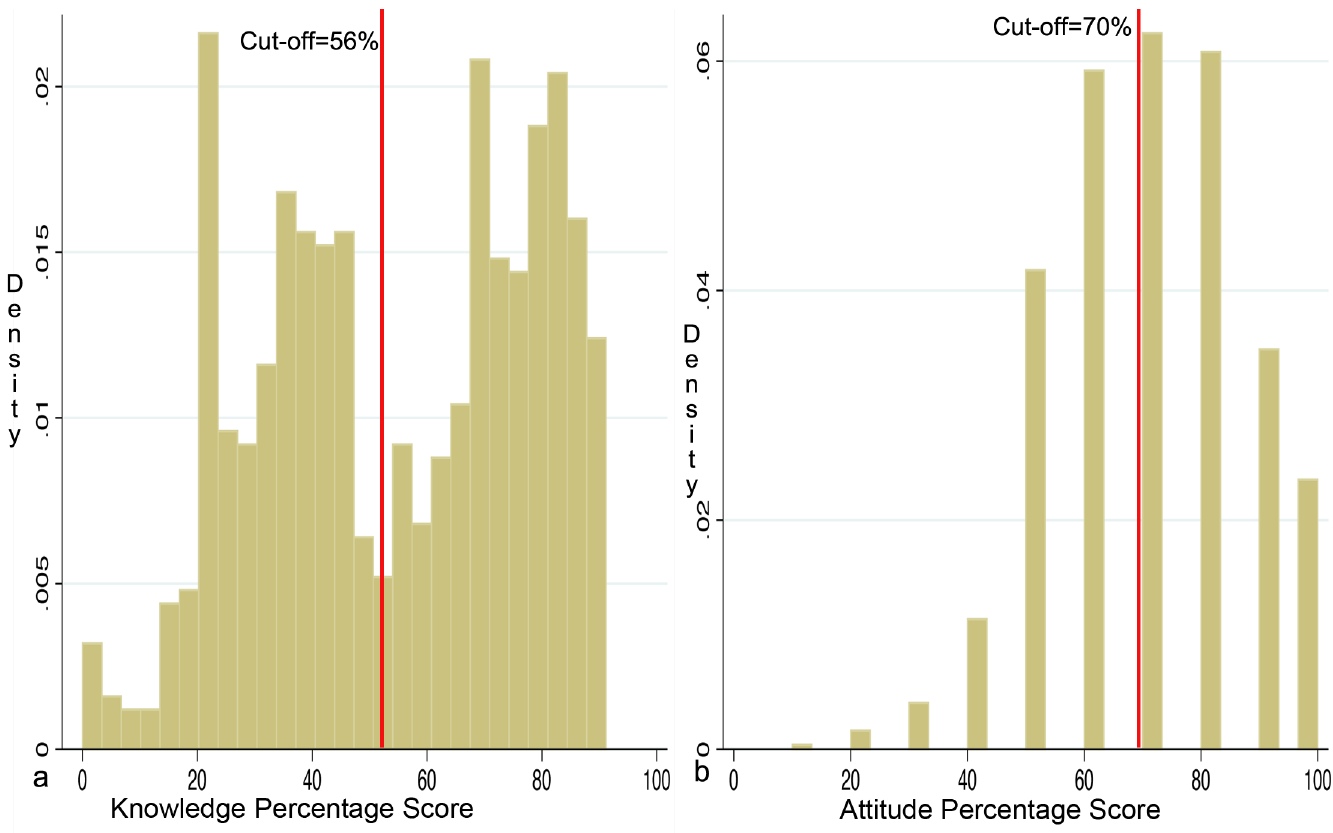
Fig 2. a: Distributionof percentageknowledgescores; the red line shows cut-off set at a medianscore of 56%. b: Distributionof percentage attitude scores; the red line shows cut-off set at a medianscore of 70%.